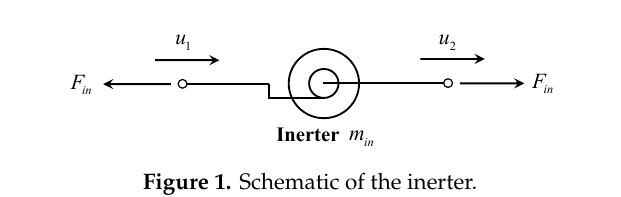
Figure 1. Schematic of the inerter.